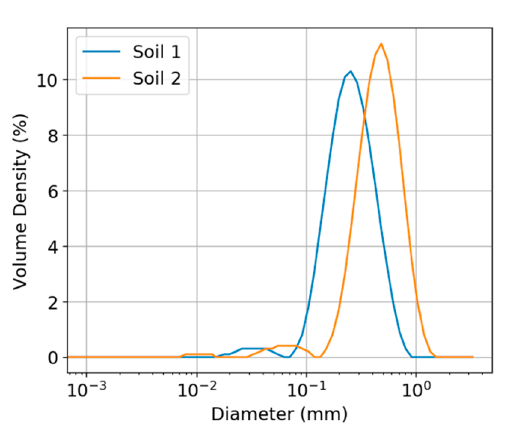
Figure 2. Particle size distribution of soils sampled from the Rotem Plateau in Israel. Table 2. Particle size distribution (by volume) properties of soils from the Rotem